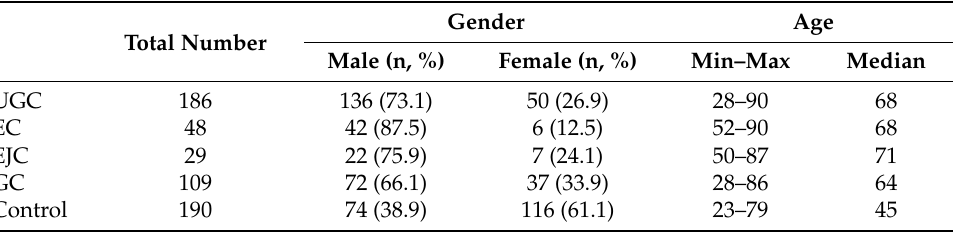
Table 1. Characteristics of participants enrolled in this study.